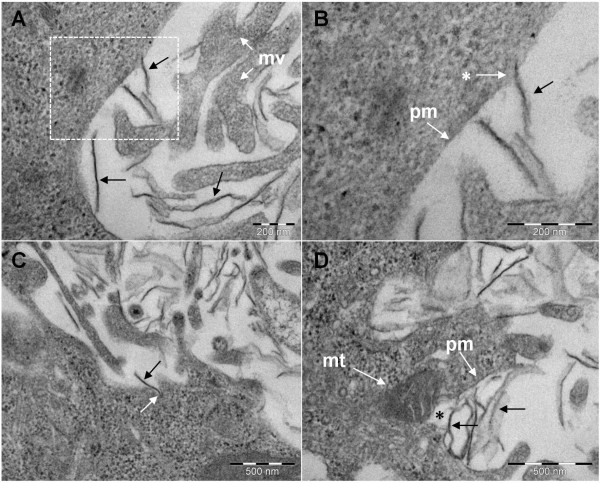
Interaction of GO nanoplatelets with the plasma membrane of Hep G2 cells. A) SEM micrograph showing the interaction of GO nanoplatelets (exemplarily indicated by black arrows) with the plasma membrane (pm) and microvilli (mv). B) SEM micrographs showing the boxed-in area in A at higher magnification. GO nanoplatelet penetrating the plasma membrane (arrow with white asterisk). C) Membrane invagination (white arrow) at the site of interaction of a GO nanoplatelet (black arrow) with the plasma membrane. D) Disruption of the plasma membrane (black asterisk) at the site of interaction with GO nanoplatelets (exemplarily indicated by black arrows). Scale bars represent 200 nm in A and B, and 500 nm in C and D. Black arrows exemplarily indicate GO nanoplatelets. mt: mitochondrion, pm: plasma membrane, mv: microvilli.